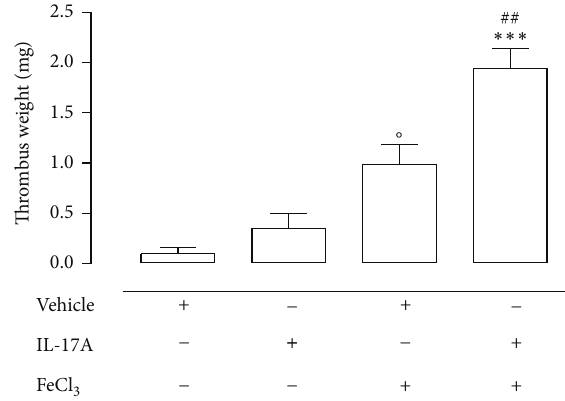
Figure 1: Effect of IL-17A on thrombus mass induced by FeCl 3 application on rat carotid artery. A filter paper soaked in FeCl 3 (5%) or in recombinant mouse IL-17A (100 𝜇 g/mL) was applied onto the external surface of the right carotid artery, for 30 minutes; afterward the paper was removed and the vessel was left in situ for 60 minutes, to enable thrombus formation. In another set of experiments, an IL- 17A (100 𝜇 g/mL), or vehicle (HCl, 4mM), soaked filter paper was applied onto the vessel for 30 minutes before applying FeCl 3 (5%). At theend of60-minuteperiod, a piece of about 2 cm in length of the right carotid artery and of its contralateral was excised and